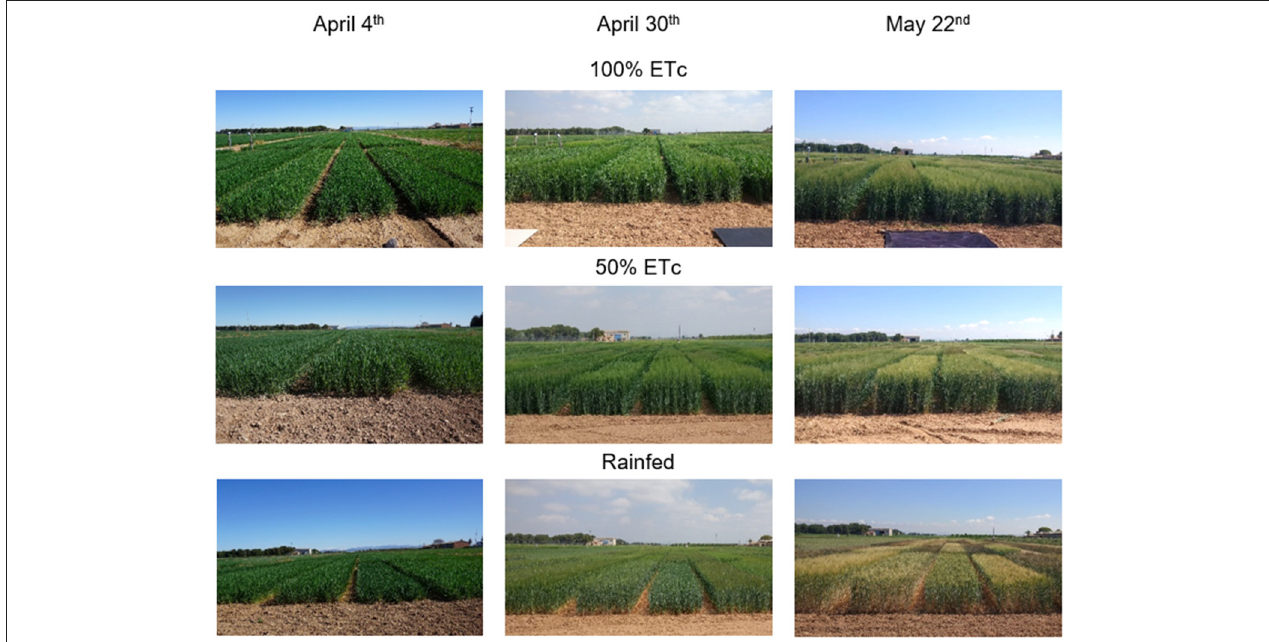
FIGURE 3 | Pictures of each irrigation treatment for the different dates of image acquisition (April 4th, April 30th, and May 22nd).